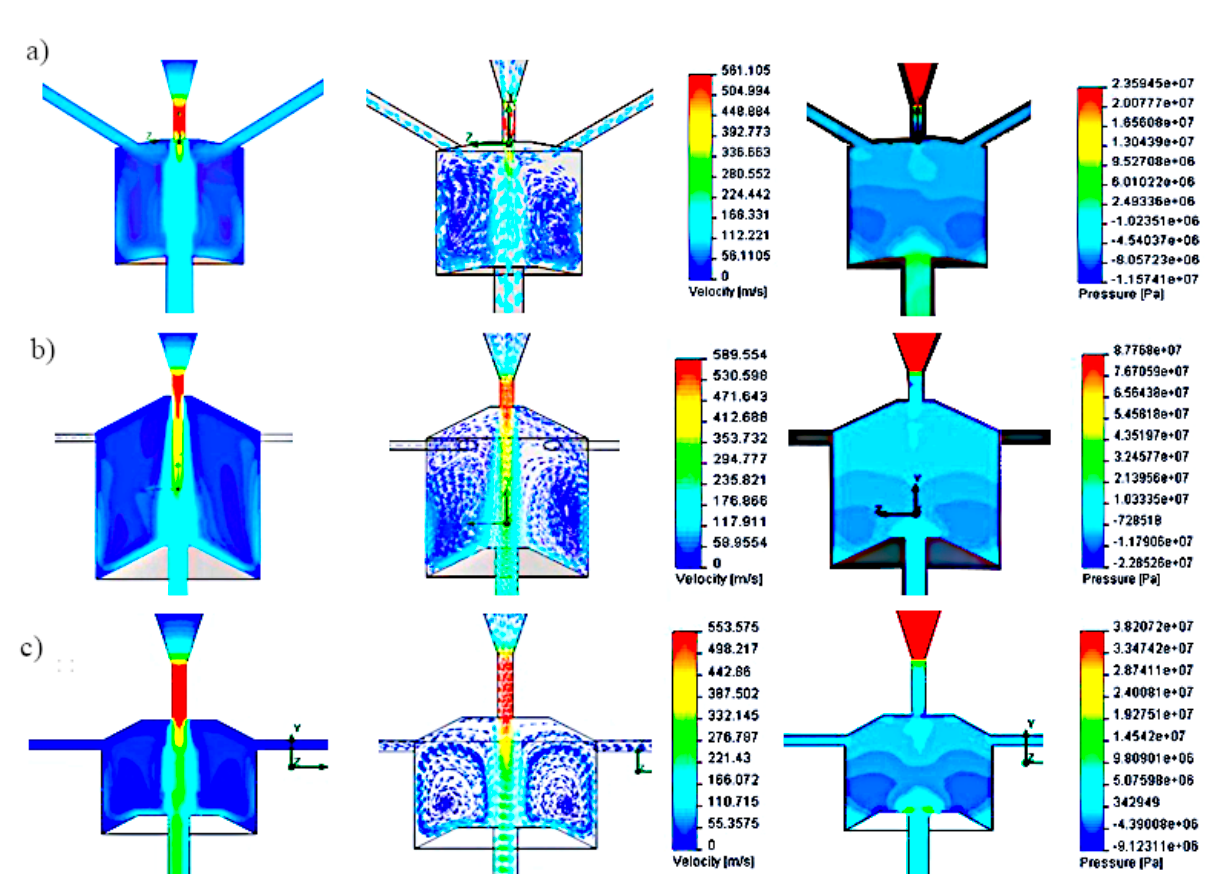
Figure 6. Graphical interpretation of velocity and pressure distributions for selected head solutions with different locations of side openings: ( a ) inclined at an angle of 120 ◦ to the axis of the head; ( b ) tangential to the swirl chamber; ( c ) perpendicular to the axis of the head.